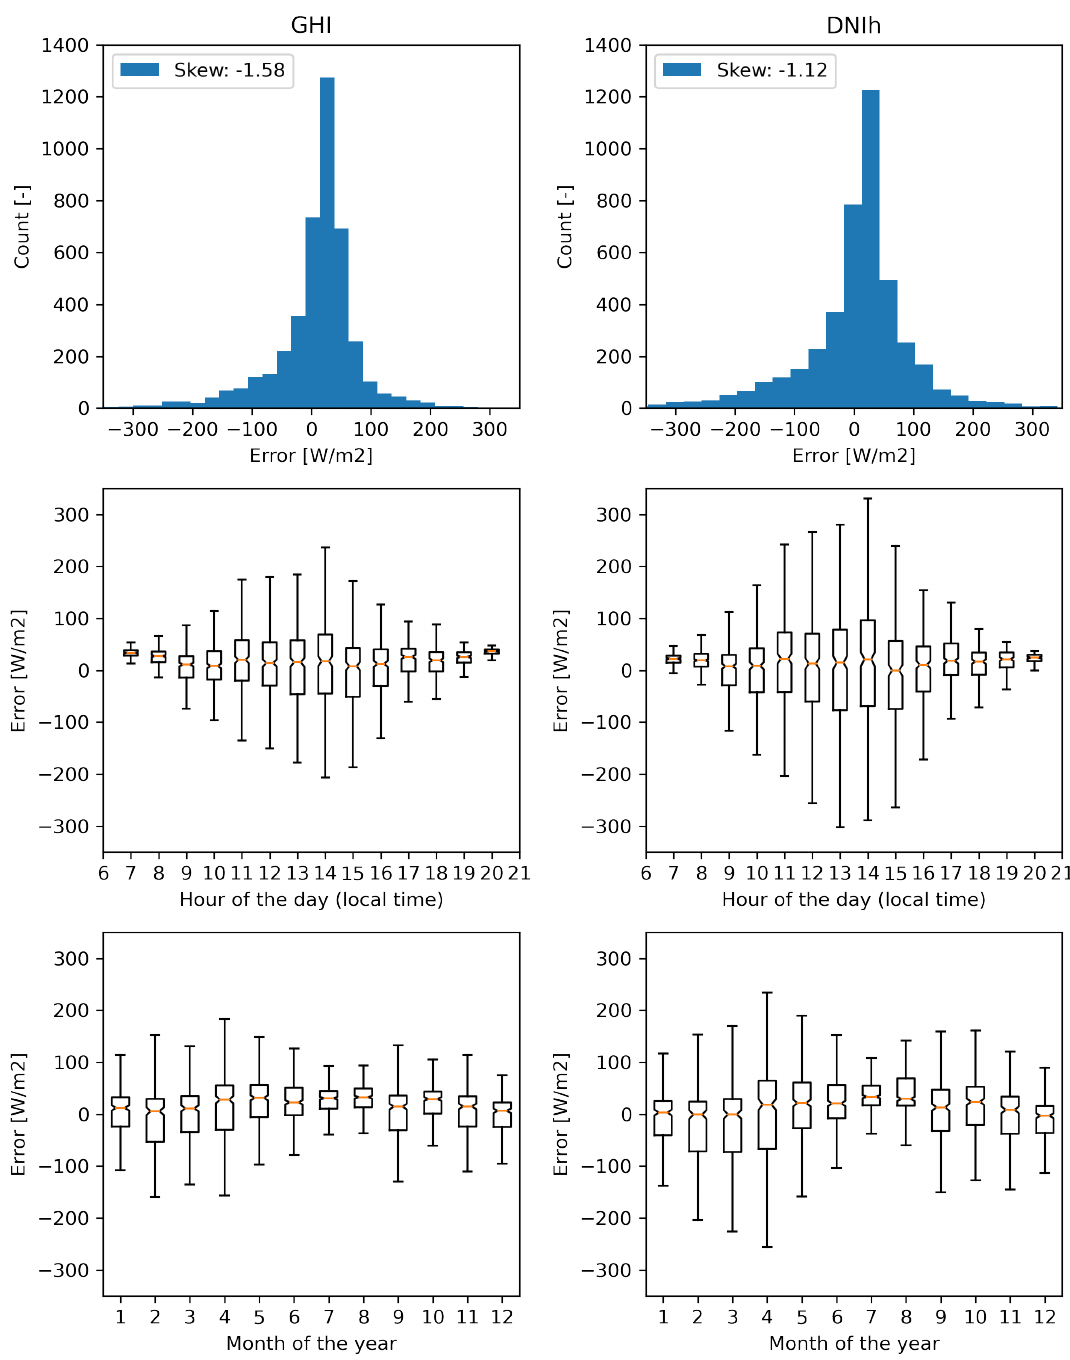
Figure 9. Errors of the modeled GHI and DNI irradiation on a horizontal surface compared to the measured values from the ERA5 dataset. Histograms (first row), box-plot grouped on the hour of the day (second row), and on the month of the year (third